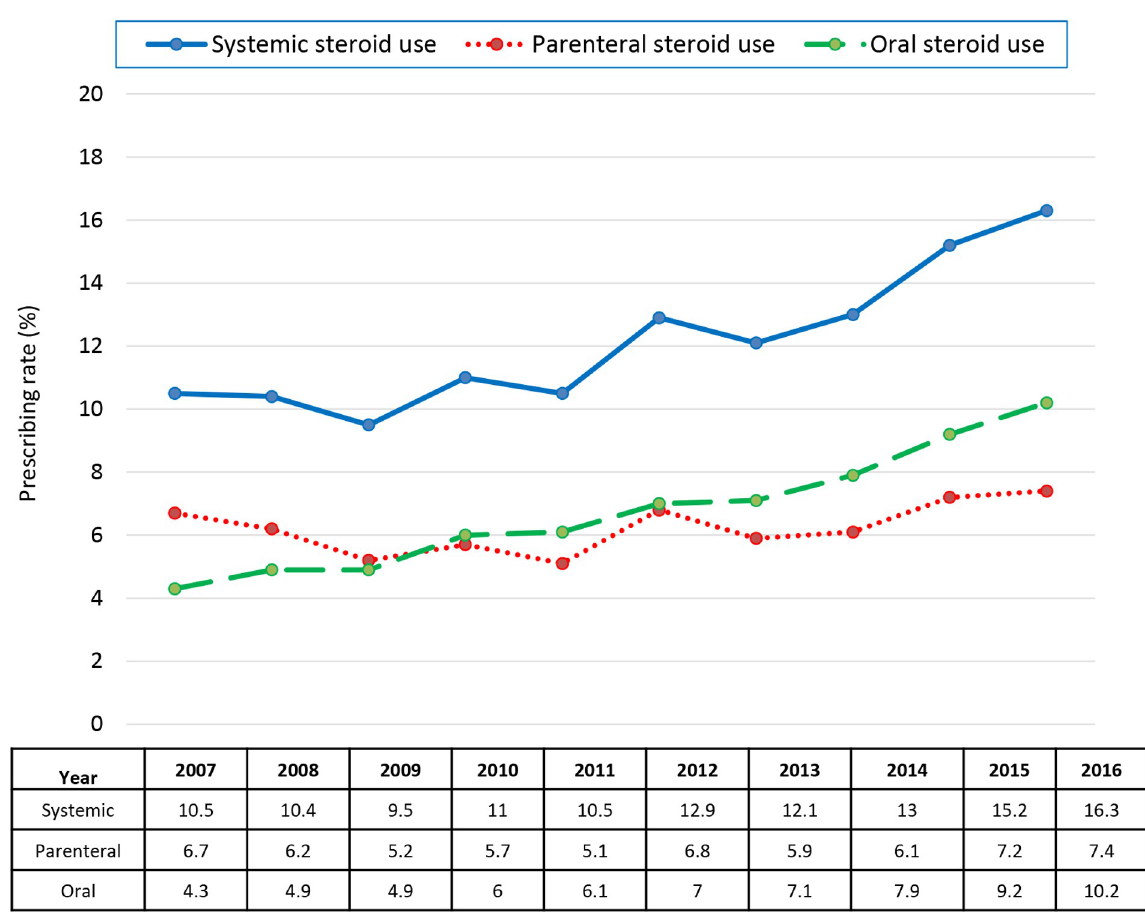
Fig 3. Time trend of prescribing rates of systemic steroids for acute respiratory tract infections.